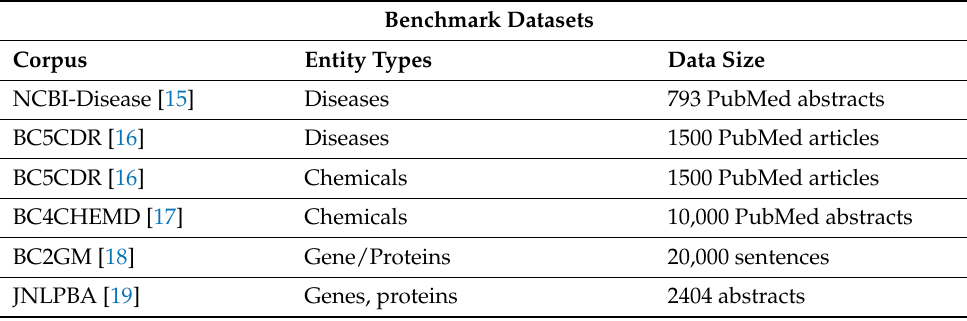
Table 1. Biomedical NER datasets and